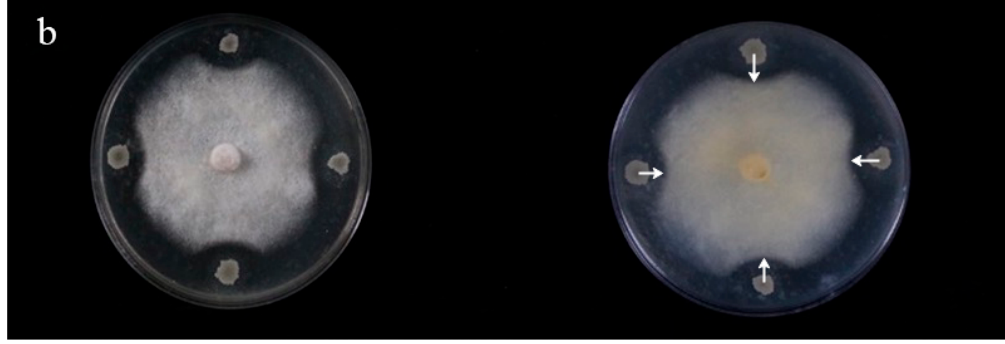
Figure 2. ( a ) The control group of Gloeophyllum trabeum . ( b ) The Inhibition zones produced by B72 strain against Gloeophyllum trabeum .